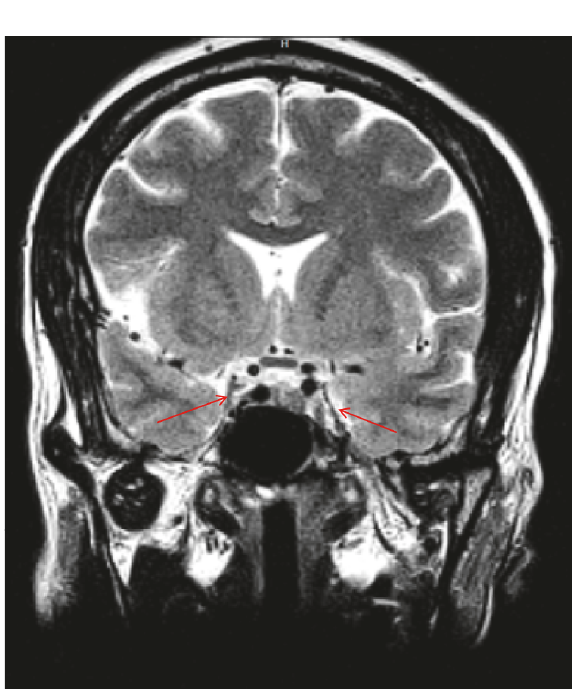
Figure 2: CoronalT1 diffusion-weightedMRI of the pituitary gland.